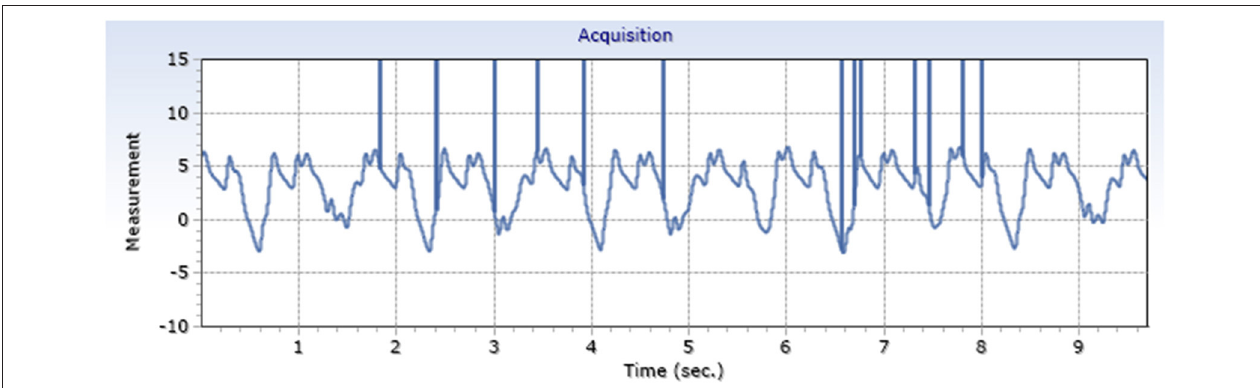
FIGURE 2 | Schematic description of experimental set up. Sensor is introduced in the animal region of interest. Light signal is transferred to the controller and translated into an electrical signal for the